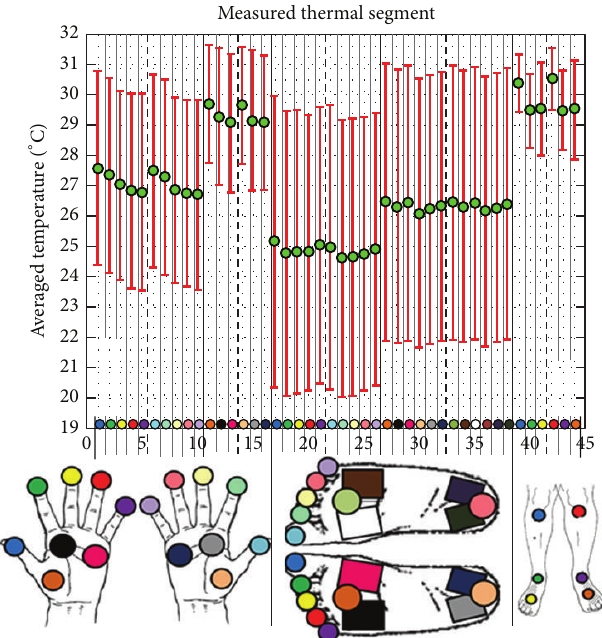
Figure 5: The mean thermographic temperature of each region (green dot) and the standard deviation across subjects for each region (red bars).